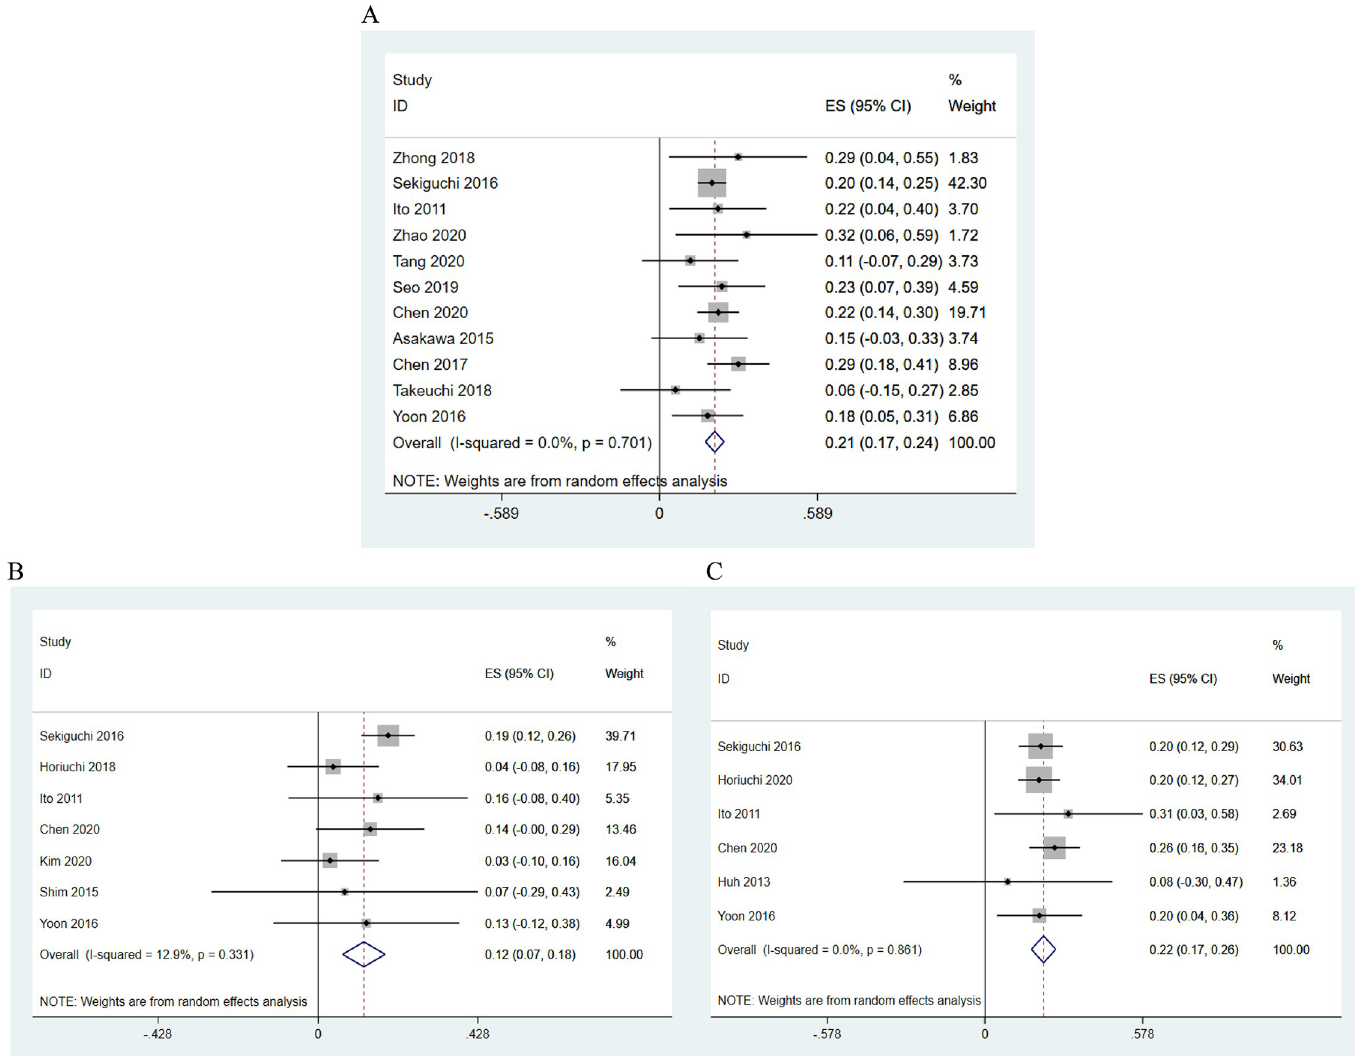
Fig 2. The rate of LNM in mixed-type early gastric cancer (A) overall, (B) for the predominantly differentiated mixed type (MD), and (C) for the predominantly undifferentiated mixed type (MU).